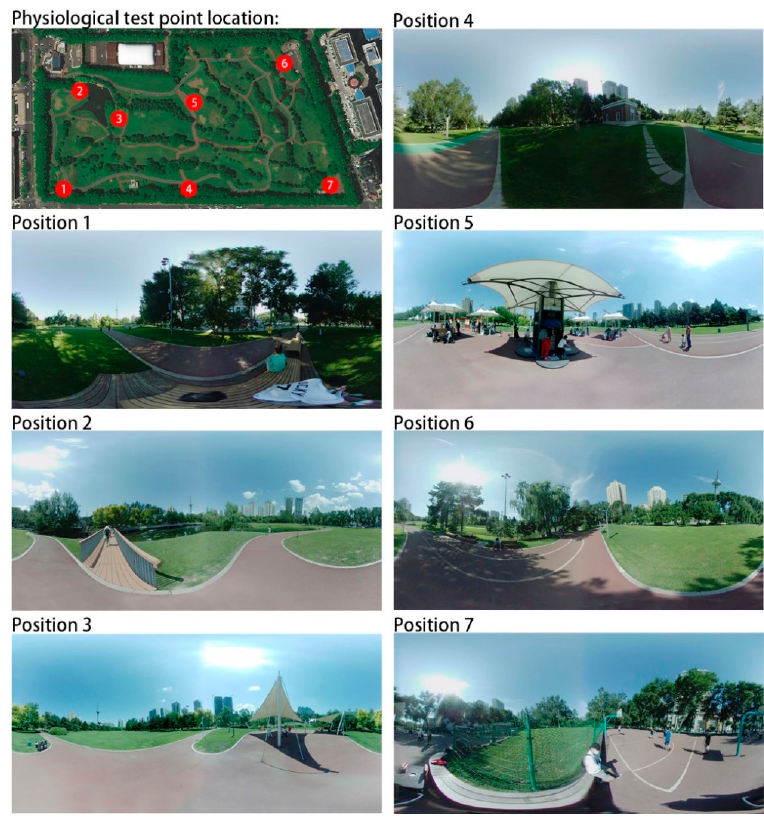
Figure 5. Physiological test point location and